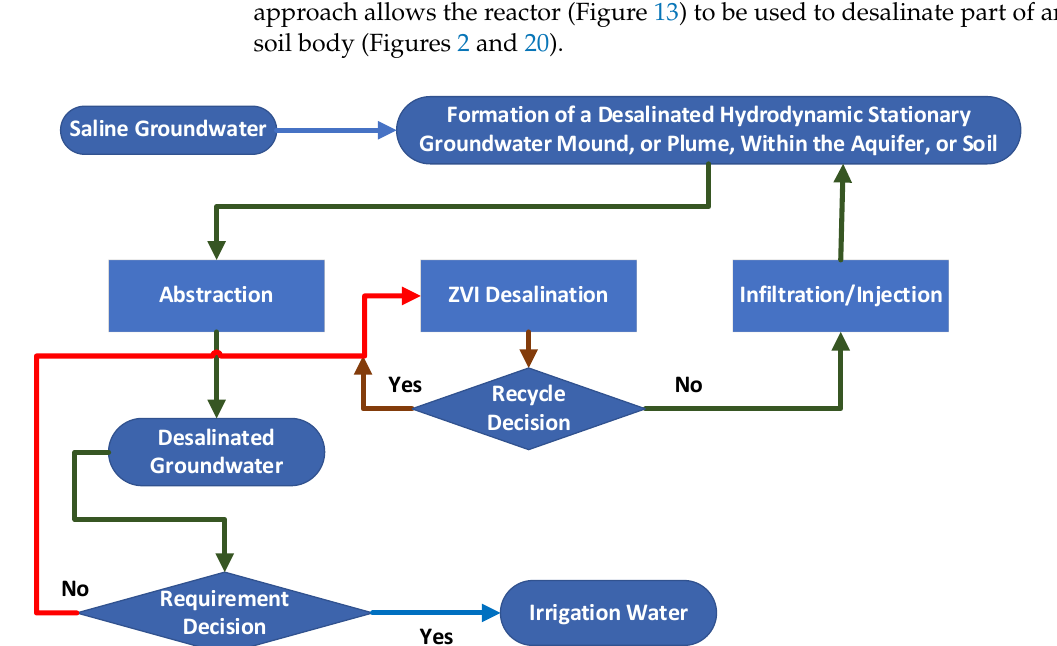
Figure 20. A flow diagram summarizing the decision process used in this study to reconstruct a hydrodynamic stationary groundwater plume or a perched stationary groundwater mound.